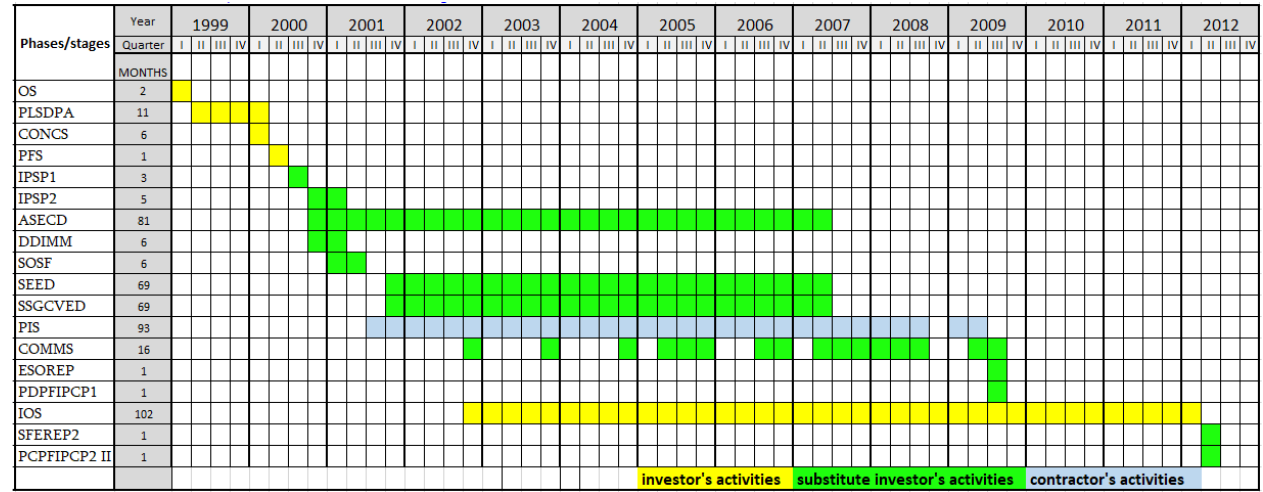
Figure 3. Gantt chart—Parkowo Le ś ne Housing Estate Project.